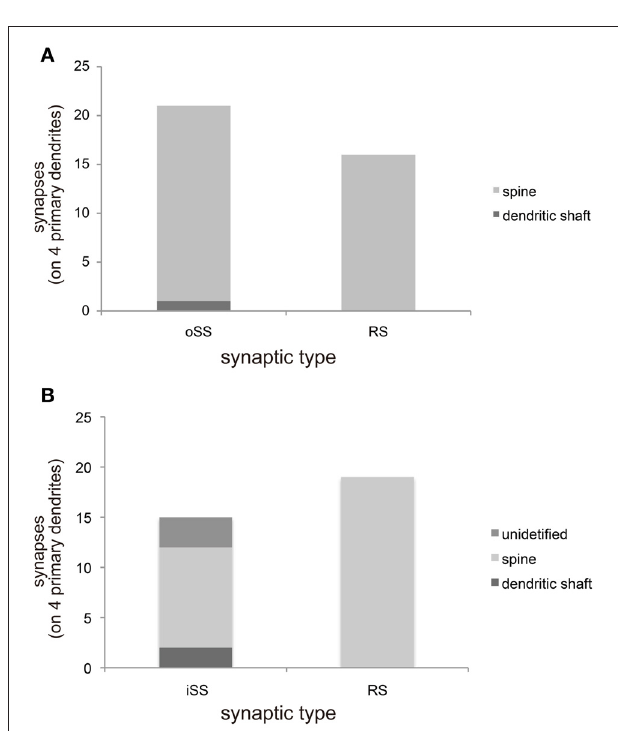
FIGURE 2 | Morphological characterizations of synaptic sites. (A) The constitution of output synapses from MT cell primary dendrites to other neurons from 4 primary dendrites. These synapses categorized by synaptic type [single synapse (oSS) or reciprocal synapse (RS)] and postsynaptic architecture of paired neurons. Most synapses formed with dendritic spines. (B) The construction of input synapses from other neurons to primary dendrites of MT cells. These synapses were categorized by synaptic type (iSS or RS) and presynaptic architecture of paired neurons. All RSs formed with dendritic spines; however, presynaptic structures of iSSs were not